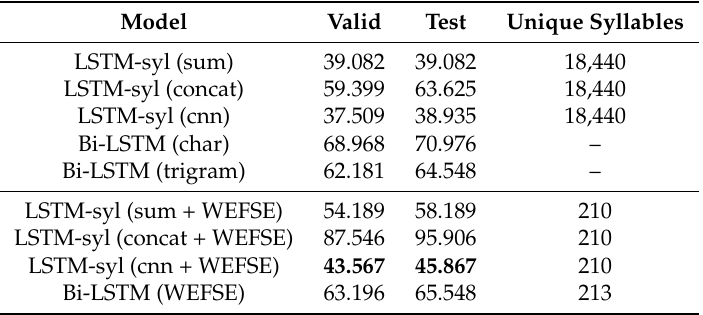
Table 4. The baseline results for the LSTM-syl [21] and Bi-LSTM [25]. Our Model (WEFSE) posts very competitive results to state-of-art on the LSTM-syl (cnn + WEFSE) model. The unit of measure is perplexity; the lower is the value, the better is the representation. The bolded values represent the best performance.